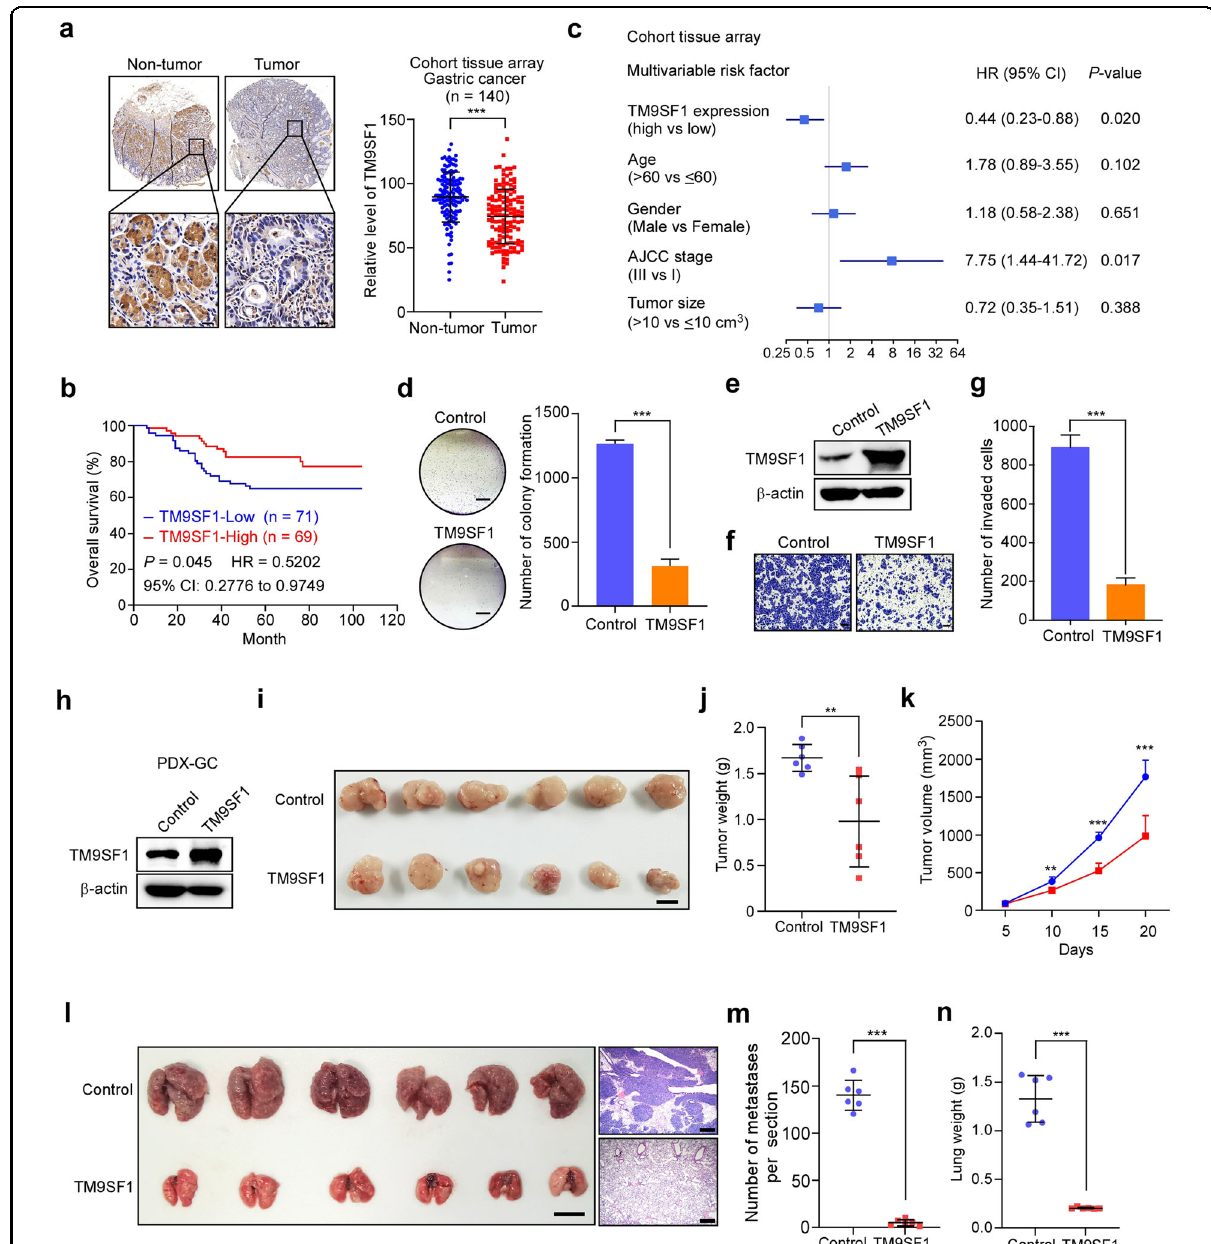
Fig. 5 TM9SF1 functions as a tumor suppressor gene in gastric cancer. a Immunohistochemistry analysis of gastric cancer tissue array probed with anti-TM9SF1 antibody. Representative images from gastric cancer tissues and their pair non-tumor tissues are presented. Immunohistochemistry scores were analyzed. Bars, 20 μ m. b Kaplan – Meier survival curves of TM9SF1 protein expression in gastric cancer tissues from cohort tissue array with best cutoff. c Multivariable risk factor analyses of cohort tissue array. All the bars correspond to 95% CI. HR hazard rate. d Colony formation assays of BGC-823 cells infected with control or TM9SF1 expression lentivirus. Representative images of cell colonies are shown. The colonies were quanti fi ed. Scale bars, 5 mm. e Con fi rmation of TM9SF1 overexpression in BGC-823 cells with control or TM9SF1 expression lentivirus by western blot analysis. f , g Migration analysis of BGC-823 cells infected with control or TM9SF1 expression lentivirus. Representative images of invaded cells are presented ( f ). The invaded cells were counted ( g ). Scale bars, 100 μ m. h – k PDX-GC cells infected with control or TM9SF1 expression lentivirus were subcutaneously injected into BALB/C nude mice. The expression of TM9SF1 protein was determined by western blotting ( h ). The images of tumors in each group are shown ( i ). The average weight of tumors in each group was also analyzed ( j ). The tumor volume was measured every 5 days, and the growth curves were generated ( k ). Scale bar, 1 cm. l – n PDX-GC cells were overexpressed with TM9SF1 and intravenously injected into SCID mice. Gross lungs (Scale bars, 1 cm) and representative H&E images (Scale bars, 400 μ m) are presented ( l ). Statistics analyses of pulmonary metastases ( m ) and lung weight ( n ) are shown. Data are expressed as means ± SD. ** P < 0.01, *** P < 0.001, paired t -test ( a ), Mann – Whitney test ( j , m , n ), Student ’ s t -test ( d , g , k